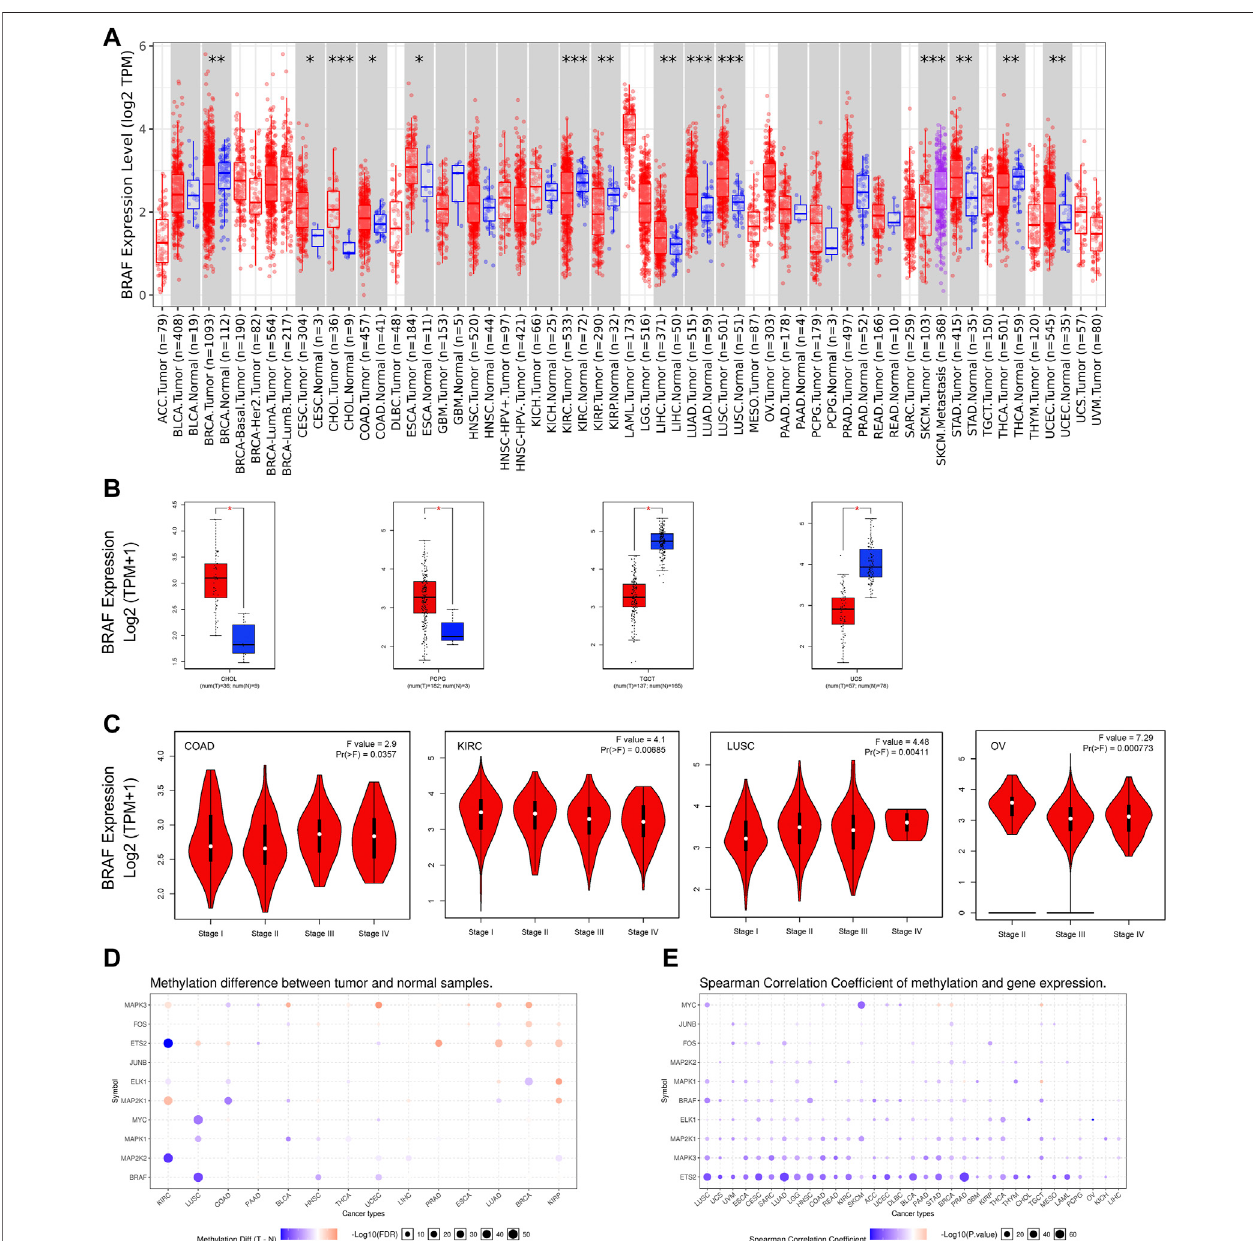
FIGURE1| BRAFmRNAexpressionandDNAmethylationinTCGAtumortissues. (A) BRAFmRNAexpressionacrossdifferentcancertypesbyTIMER2.Thelog2 [TPM (Transcripts per million)] was applied for the log-scale. (B) Differential expression of BRAF between tumors samples and normal tissues using combined data from TCGAand GTEx datasetsbasedontheGEPIA2 portal. BRAFexpression wasup-regulated inCHOL andPCPG,but down-regulated inTGCT andUCS. Thelog2(TPM + 1) was applied for log-scale. (C) Differential expression of BRAF in different pathological stages of COAD, KIRC, LUSC, and OV. The log2 (TPM + 1) was applied for log-scale. (D) Bubble map depicting the methylation difference of BRAF and its downstream genes between tumors and normal samples. Blue dots indicate down- regulatedmethylationintumors.Red dotsindicate up-regulated methylation. (E) Bubble mapexhibitingcorrelationsbetweenmethylationand geneexpression ofBRAF and its downstream genes. Blue dots denote down-regulated methylation in tumors. Blue dots represent the negative Spearman correlation coef fi cient, and red dots represent the positive. * p < 0.05; ** p < 0.01; *** p < 0.001.